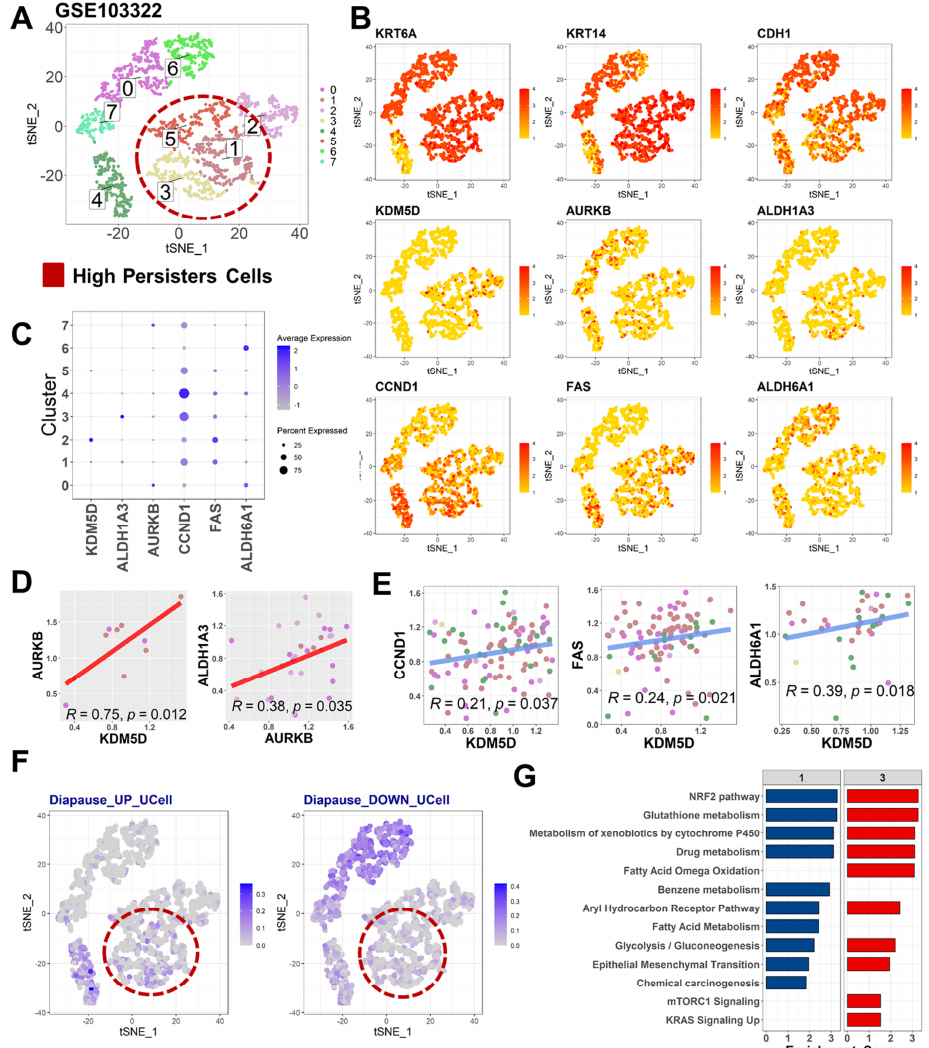
Figure 3 Figure 3. KDM5D and AURKB co-expression delineates cluster of HNSCC persister cells. ( A )